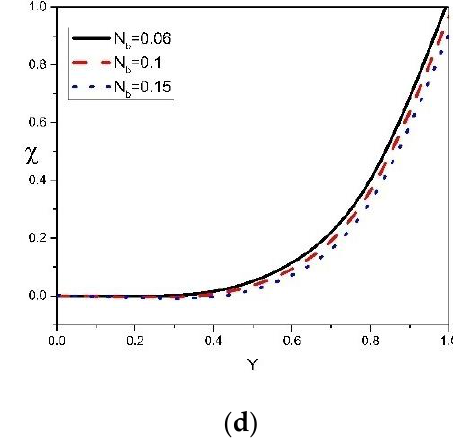
Figure 5. ( a – d ) Volume fraction distribution versus Y for various physical parameters ( a ) N = 0.7, N = 0.7, N = 0.5, N t = 0.5, P r = 7, ( b ) N CT TC b R d = 0.5. ( c ) N CT = 0.7, N TC = 0.7, R d = 0.5, N t = 0.5, P r = 7, ( d ) N CT = 0.7, N TC = 0.7, N b = 0.5, R d = 0.5, P r =